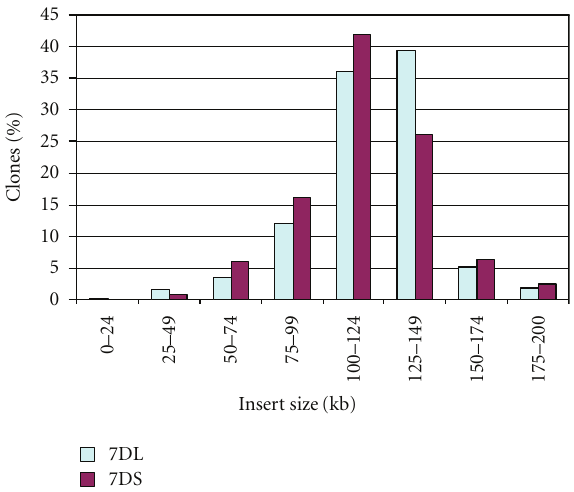
Figure 2: Insert size distribution in 7DL- and 7DS-specific BAC